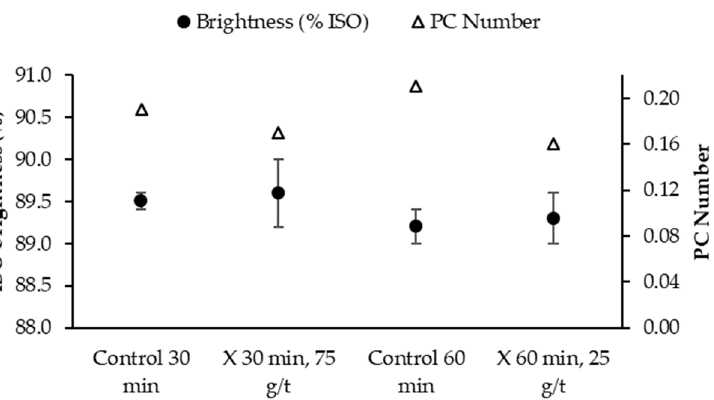
Figure 3. Effect of the bleaching sequences on pulp brightness and brightness stability (PC number).